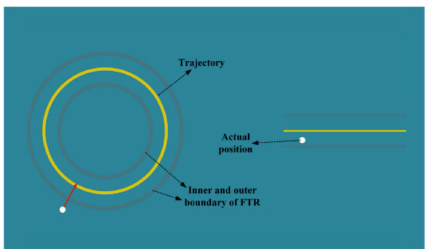
Figure 9. The screenshot of the Unity scene for the testing.